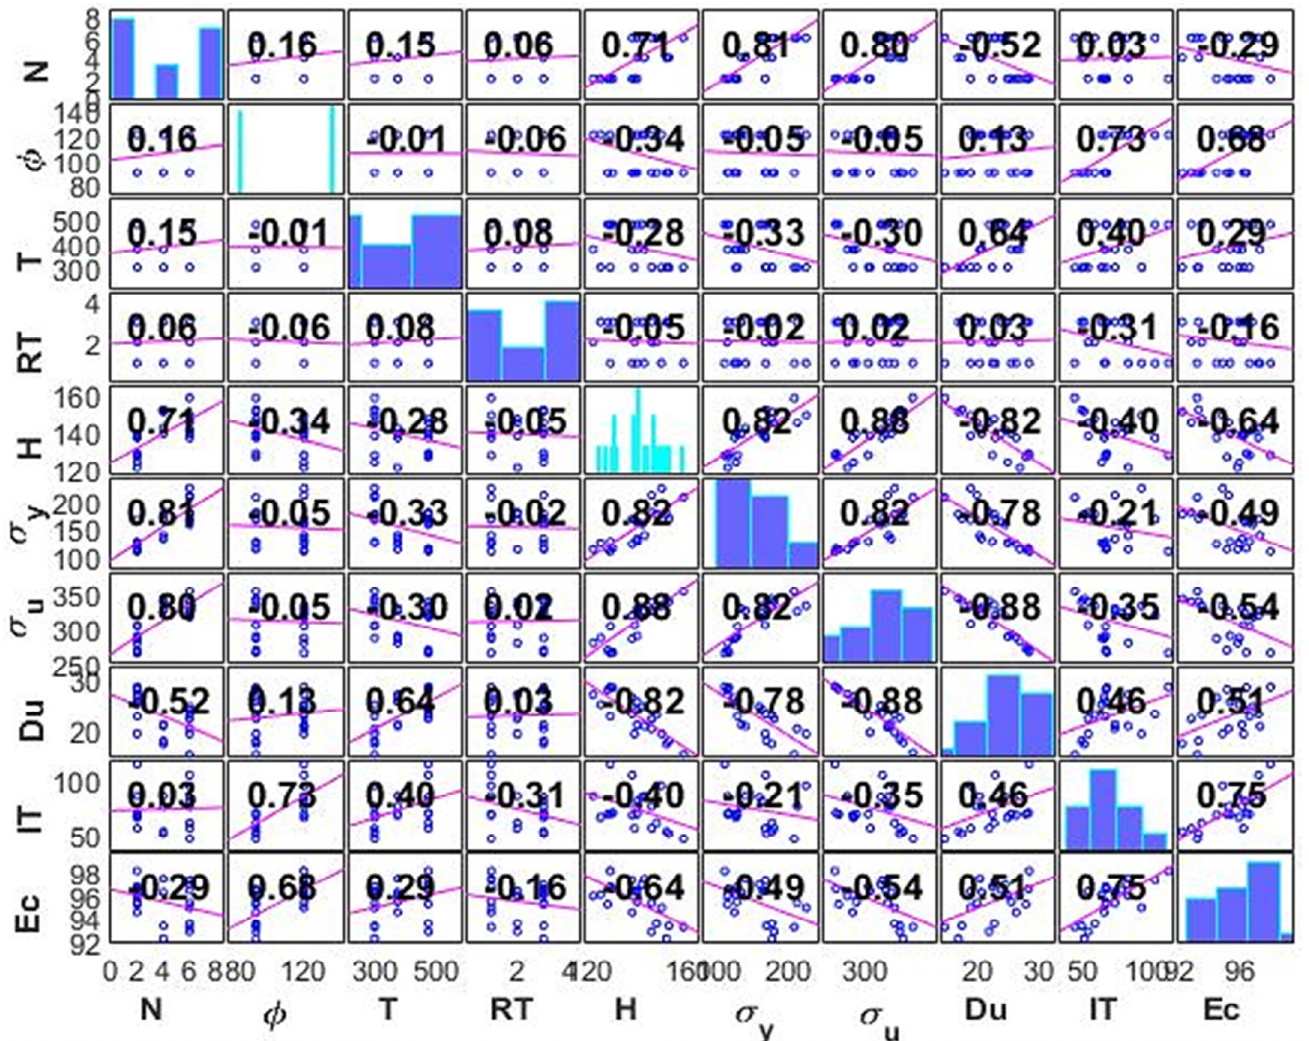
Figure 7. Correlation plots of all response ECAP parameters (HV, σ y , σ u , D u , I T , and E C ) versus Alloy feature parameters (N, ϕ , T, and RT).